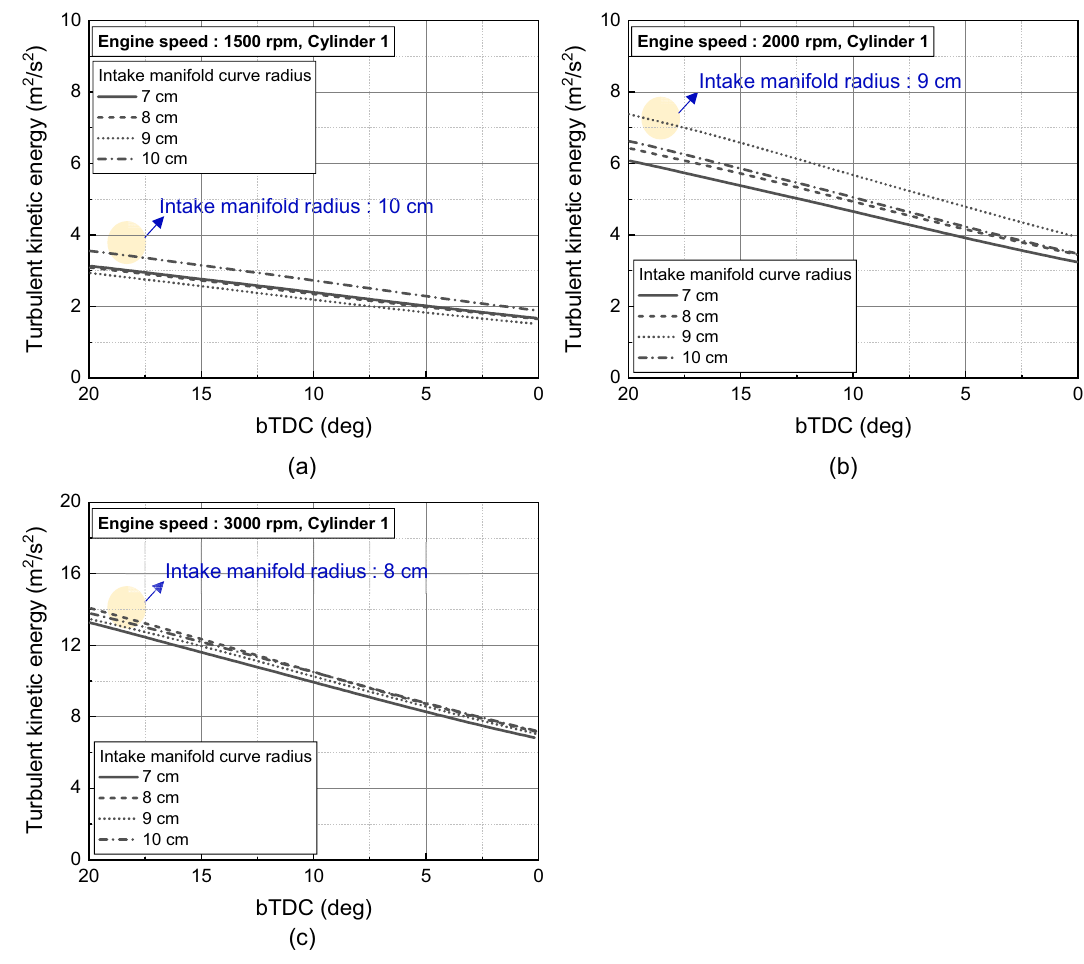
Figure 26. In-cylinder turbulent kinetic energy near TDC for different intake manifold radius at engine speed of ( a ) 1500 rpm, ( b ) 2000 rpm, and ( c ) 3000 rpm.